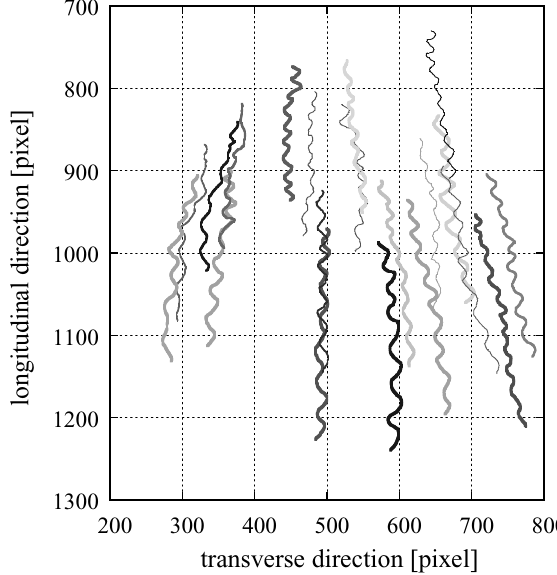
Fig. 10. An example of human walking paths obtained by tracking